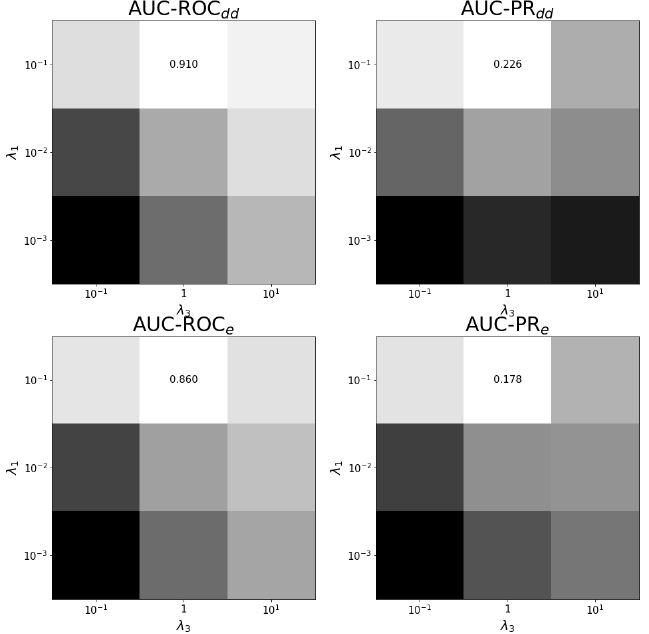
Figure A4. Tuning regularization parameters for task (cid:98) dde at optimal λ 2 . The average performance on ten training folds using shortcuts for leave-out validation is shown for different combinations of regularization parameters. The optimal combination and values are shown. White corresponds to the highest performance and black to the lowest. Each panel has a different color scale as performance varies over different scales.